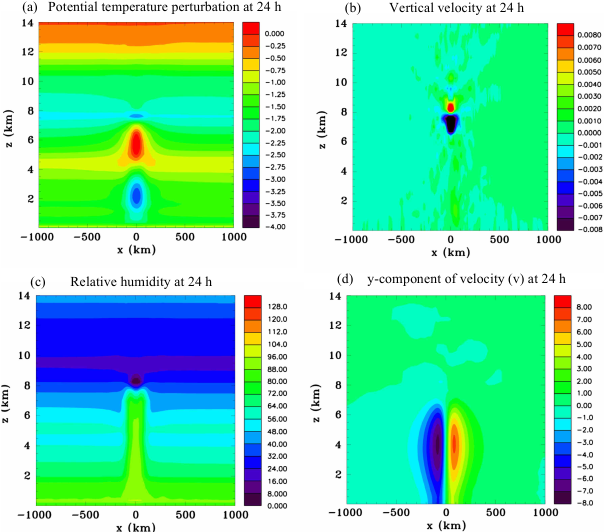
Figure 18. Vertical sections for Experiment 12: the radiation scheme activated in the environment, r > 200km. (a) Radiative flux convergence (Ks − 1 × 10 − 5 ), (b) vertical velocity (ms − 1 ), (c) rel- ative humidity, and (d) relative humidity perturbation, at t = 10h.